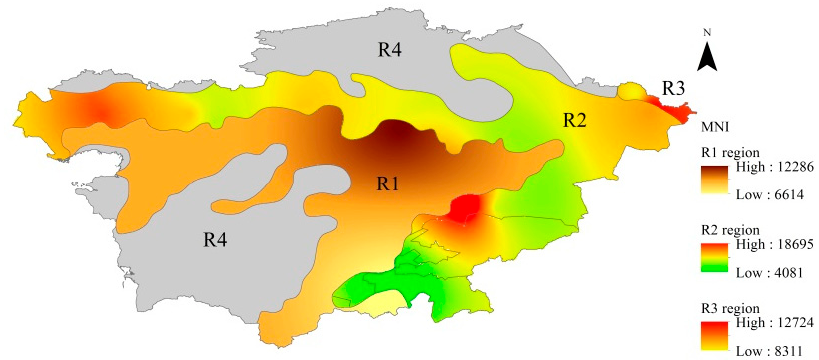
Figure 4. MNI distribution in three vegetation zones for the 2001–2015 period.